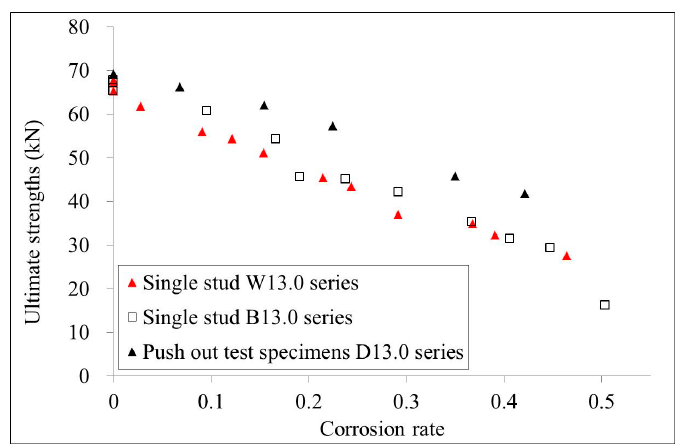
Figure 12. Comparison of the ultimate strengths of W13.0, B13.0, and D13.0 series specimens.